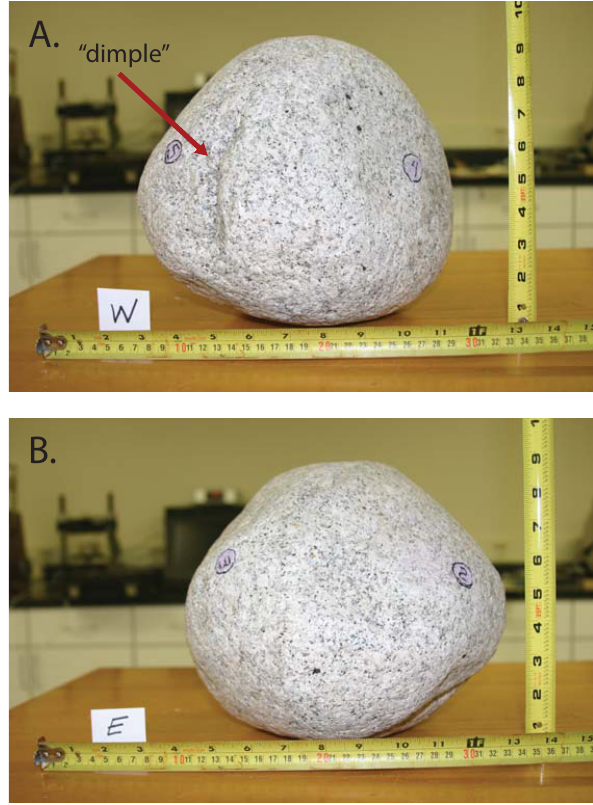
Fig. 1. Photographs of two different views of the granite boulder selected to be the test specimen for the instrumentation campaign described in this